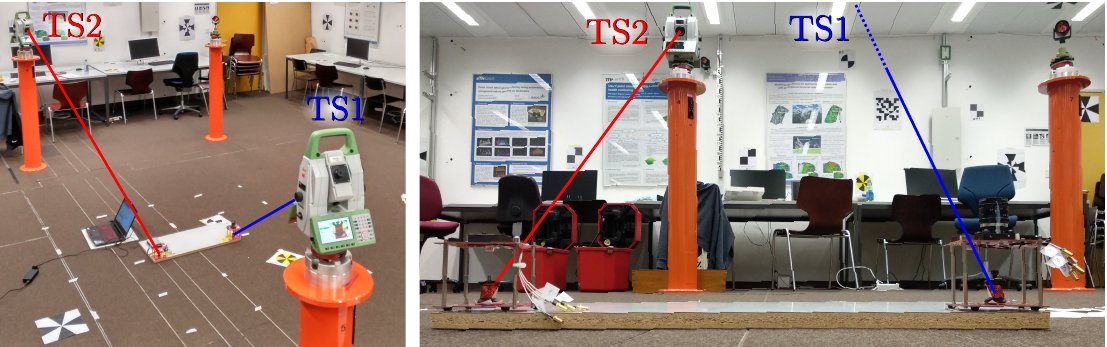
Figure 6. Receiver targeted by the total stations.